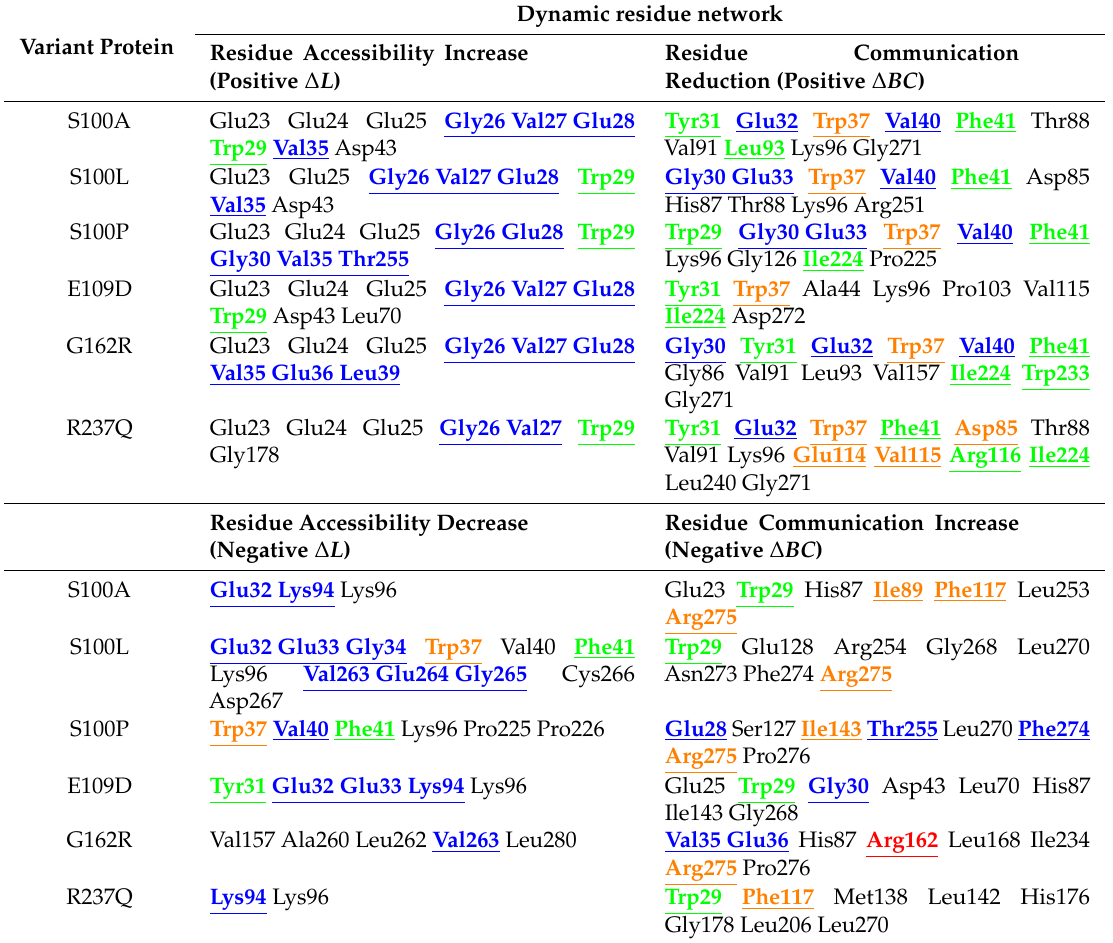
Table 3. Variant residues showing changes to ∆ L and ∆ BC in Figure S4. SNV positions are underlined, italicised and highlighted in bold red. Residues located within the CA-VIII binding site are underlined and highlighted in bold blue. Residues potentially important to CA-VIII stability are underlined and highlighted in bold orange. Overlapping potential protein-protein interaction and important structural residues are underlined and highlighted in bold